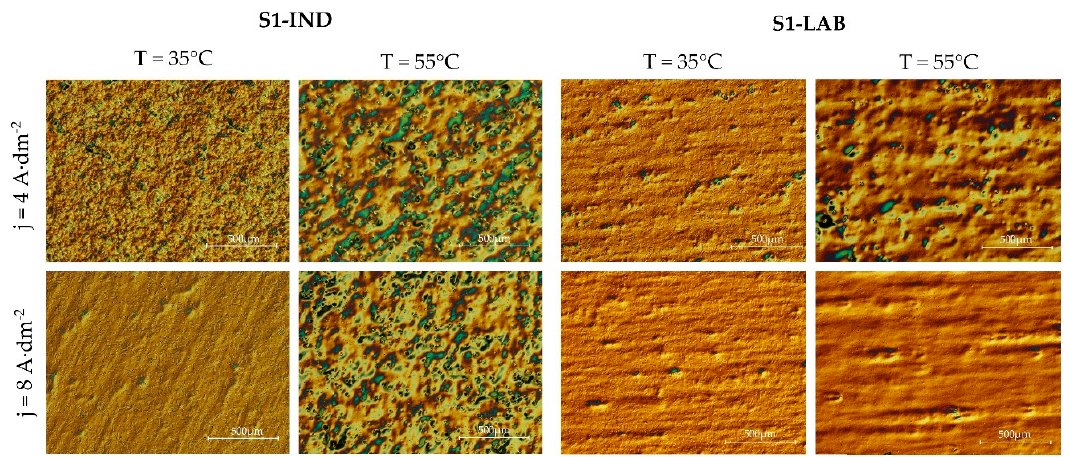
Figure 3. Metallographic photos taken with use of Nomarski contrast of the surface of chromium-nickel steel after the electropolishing.